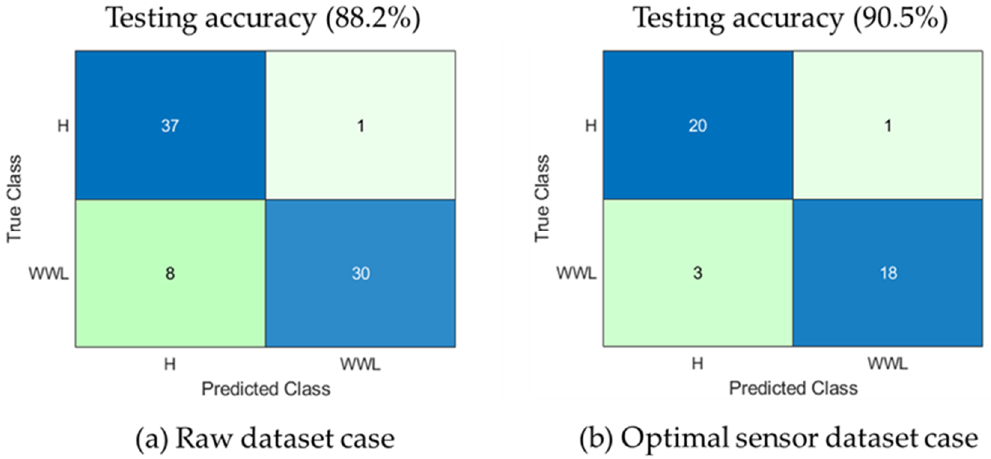
Figure 10. Confusion chart of the SVM-based machine learning model for the ( a ) raw dataset case and ( b ) optimal sensors dataset case.